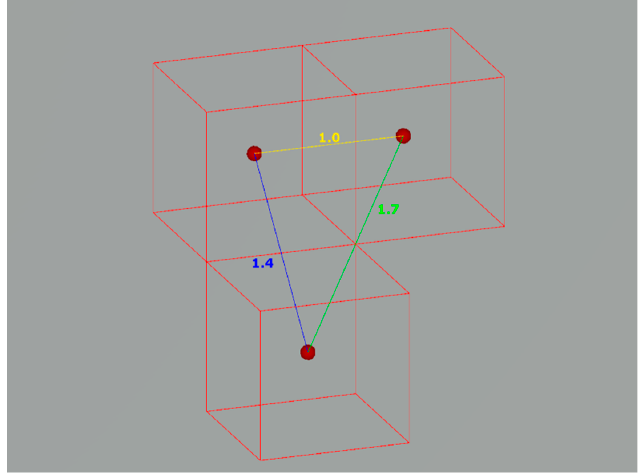
Figure 2. A representation of the three different types of movements allowed in a 3D grid with the related distance costs.